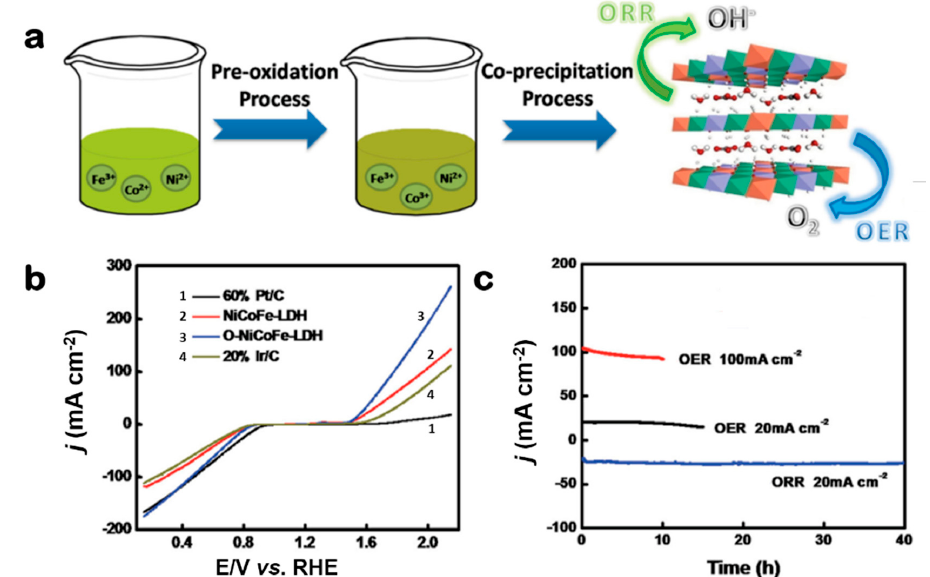
Figure 16. ( a ) Schematic chemical synthesis route and crystal structure of peroxidized ternary LDH bifunctional catalyst; ( b ) The global polarization curves of various catalysts loaded onto Teflon- treated carbon fiber paper (T–CFP) in O 2 -saturated 6 M KOH electrolyte with a scan rate of 1 mV s − 1 , the mass-loading of 1 mg cm − 2 without iR -compensation; ( c ) ORR (cathodic sweep) and OER (anodic